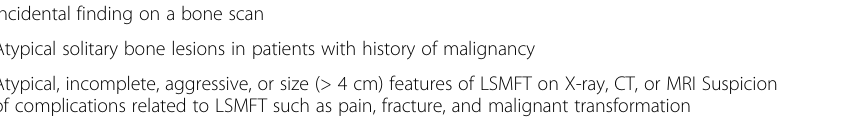
Table 1 Indications of bone SPECT/CT in patients suspected with LSMFT Incidental finding on a bone scan Atypical solitary bone lesions in patients with history of malignancy Atypical, incomplete, aggressive, or size (> 4 cm) features of LSMFT on X-ray, CT, or MRI Suspicion of complications related to LSMFT such as pain, fracture, and malignant